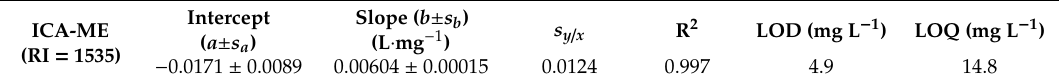
Table 3. Performance data of the methyl ester of indole-3-carboxylic acid (ICA-ME) quantification method. ICA-ME (RI =